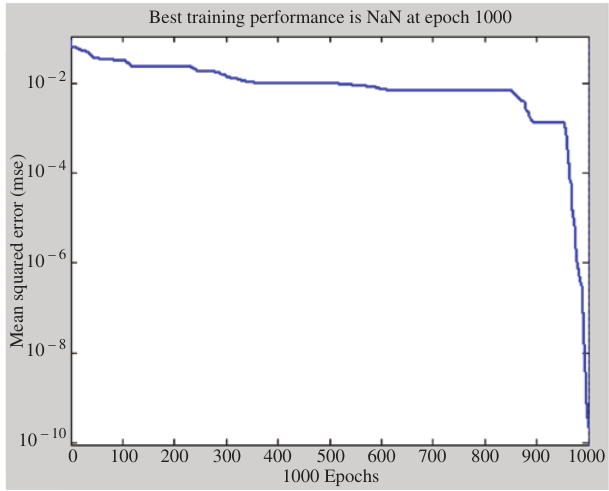
Figure 15: Performance Plot for